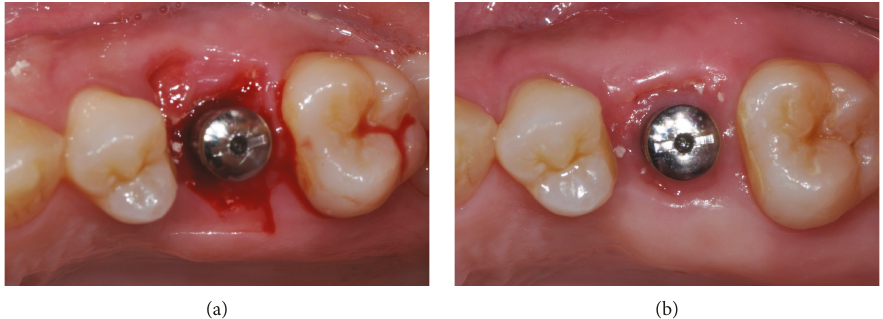
Figure 6: Other case that PRF membrane was not used for immediate implant placement in fresh maxillary molar extraction socket (tooth 26). (a) Poor healing condition of the extraction socket at 2 weeks postoperatively. (b) Healing condition of the extraction socket at 8 weeks